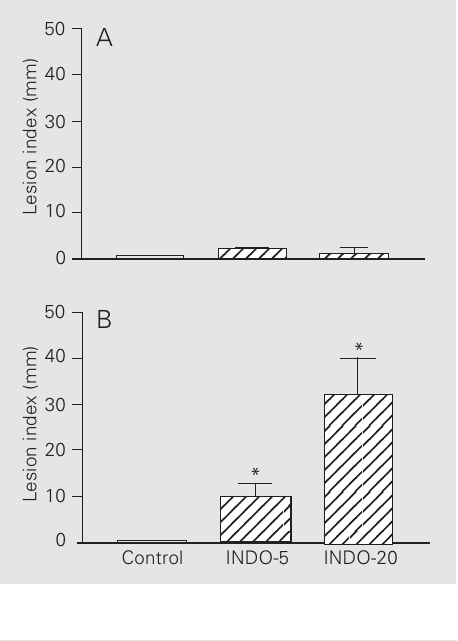
Figure 2. Recruitment of neutro- phils in the stomach, measured by a myeloperoxidase (MPO) activity assay, in rats treated with 5 or 20 mg/kg indometha- cin (INDO-5 or INDO-20) or ve- hicle (control). After 1 h (panel A) or 3 h (panel B), animals were killed and samples from the gas- tric mucosa were weighed, fro- zen and stored at -70 º C until time of the MPO activity assay. Results are presented as num- ber of neutrophils per mg tissue and reported as mean ± SEM for N = 5. *P < 0.01 compared to control (ANOVA followed by Newman-Keuls test).